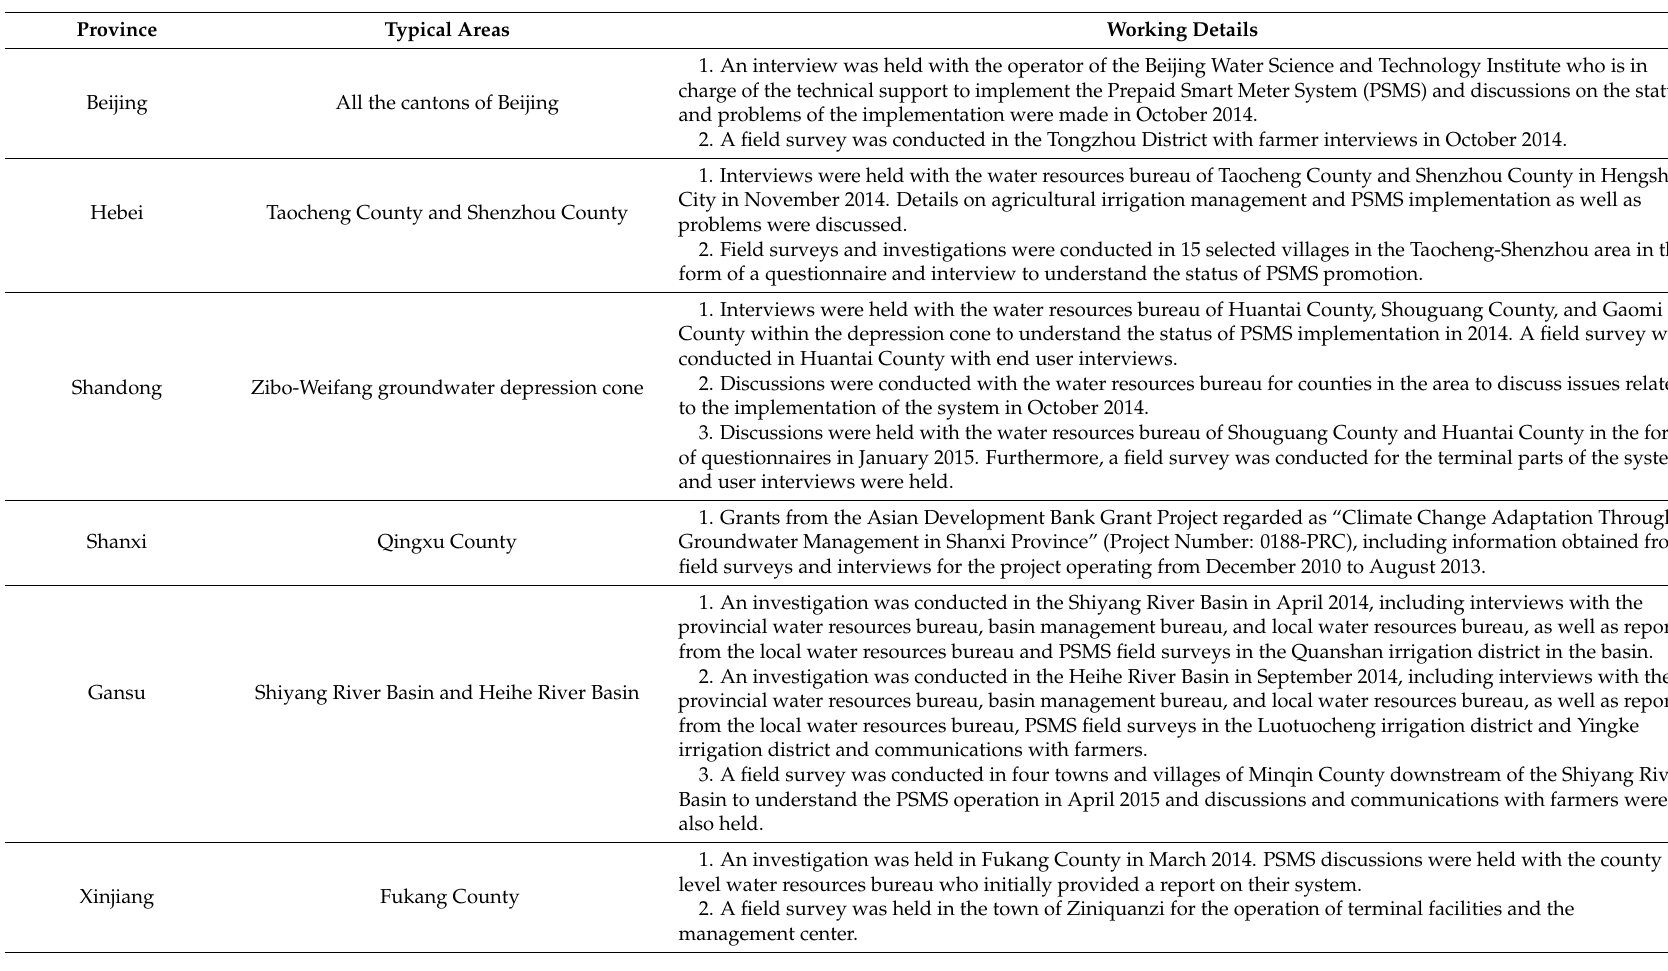
Table 1. Summary of the material collection